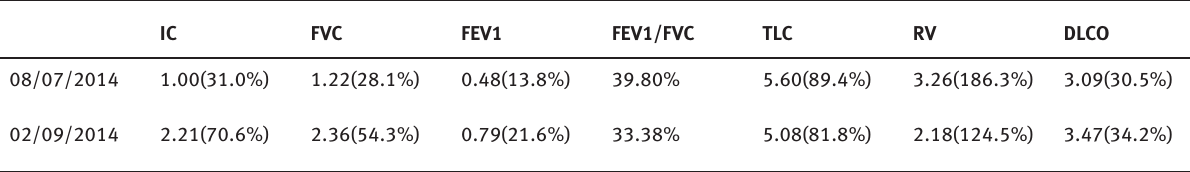
Table 1: Patient’s lung function at 2 different time